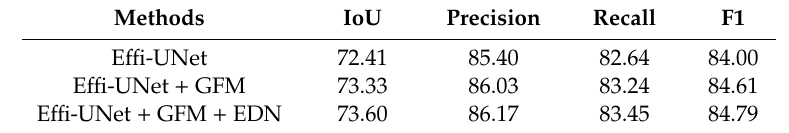
Table 1. Experimental results of each improved module on the Duke California Solar Array data set (%).